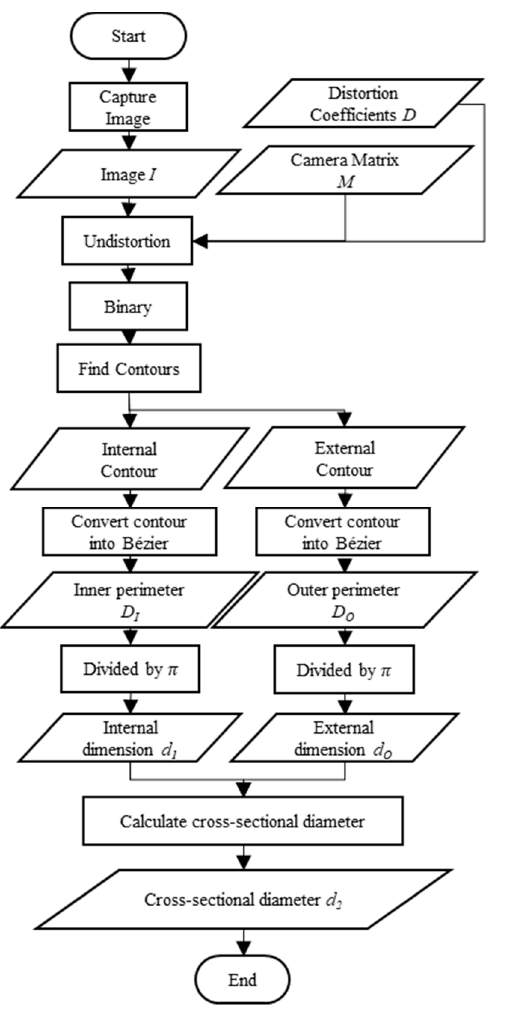
Figure 14. Flowchart of the dimension measurement.